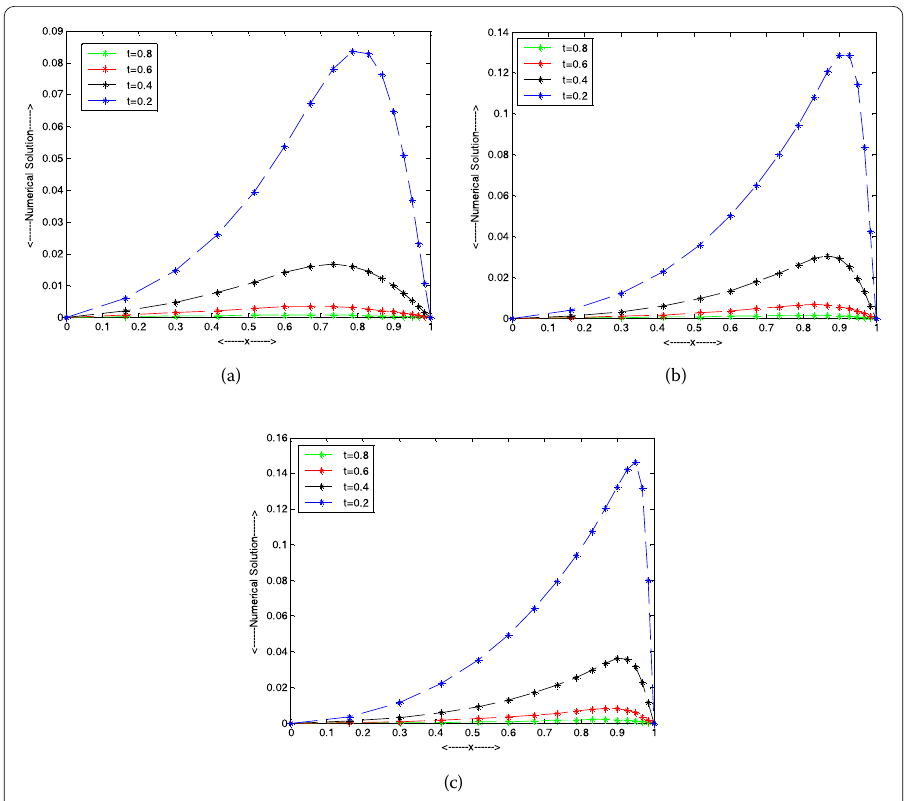
Figure 4 Example 6: Computed solutions for different time levels. (a) ε = 2 –4 , (b) ε = 2 –6 , (c) ε = 2 –7